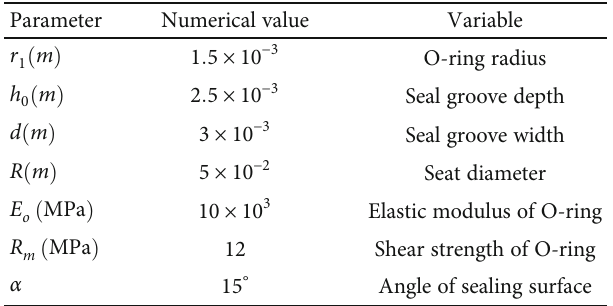
Figure 3: Sealing structure and dimension parameters of a pressure-maintaining controller. Table 1: Sealing parameters of the pressure-maintaining